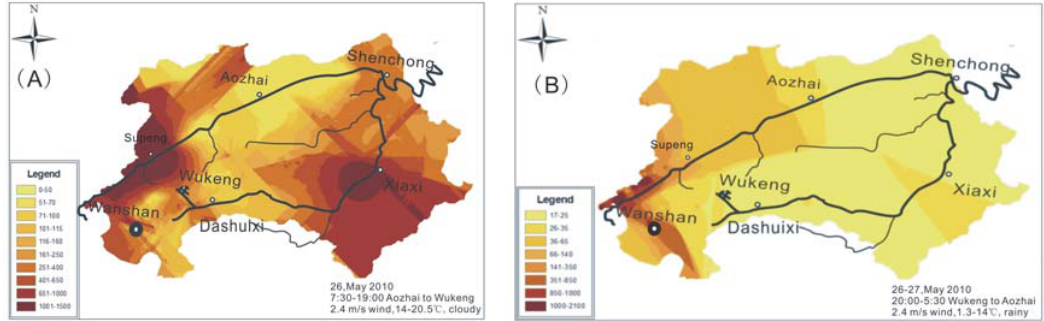
Fig. 2. Contour chart of the spatial distribution of atmospheric mercury concentration in Wanshan mining